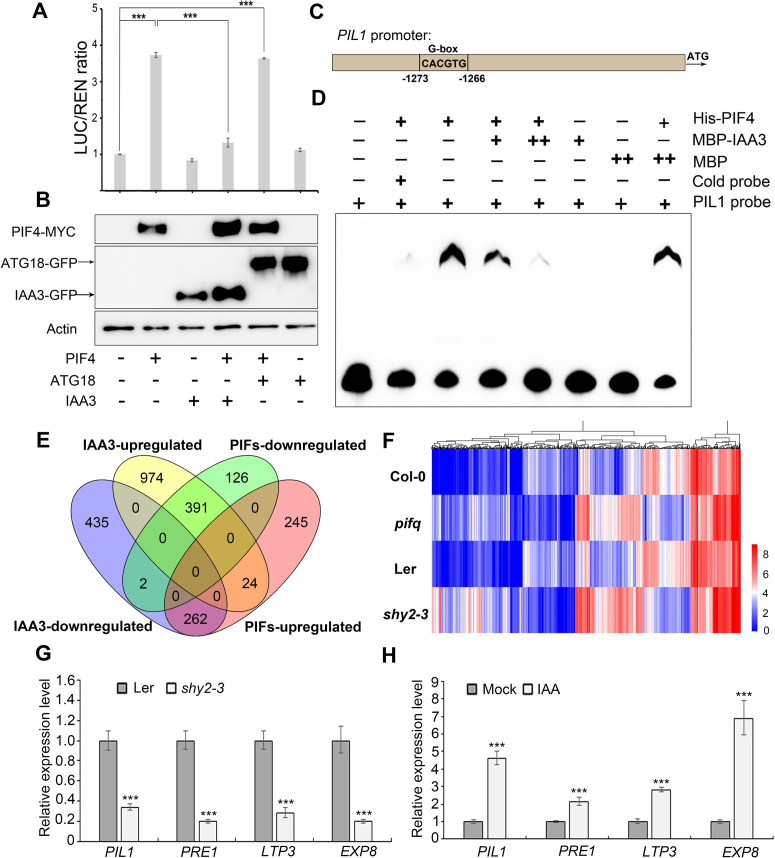
IAA3 impairs PIFs binding to DNA and negatively regulates PIFs’ target genes.(A) The transient dual-LUC reporter assay showing the effects of IAA3 on PIF transcriptional regulation of PIL1. The ATG18-GFP protein is as the negative control in the assay. Data are means ± SD (n = 3 experiments). Significant differences are indicated with asterisks (***P < 0.001, two-tailed Student’s t-test). (B) Western blotting for the detection of expressed PIF4-MYC, IAA3-GFP and ATG18-GFP in transformed tobacco leaves from (A) using an anti-MYC or anti-GFP antibody, respectively. (C) A fragment for PIL1 promoter containing G-box motif (CACGTG) was selected to used as probe in the EMSA experiment. (D) EMSA experiment showing IAA3 inhibition of the DNA-binding activity of PIFs. The cold probe was added as a competitor. MBP was used as a negative control. (E) Venn diagrams showing significant overlap between IAA3-regulated genes and PIFs-dependent genes. Detailed gene information is given in S1 Table. (F) Heat map of 625 DEGs coregulated by IAA3 and PIFs. (G) and (H) qRT-PCR analysis of known PIFs’ direct target genes. The transcription levels of PIFs’ direct target genes in Ler and shy2-3 mutant (G). Auxin induction of PIFs-regulated genes. Five-day Col-0 seedlings grown in light condition were treated with 5 μM IAA for 24 hours (H). The expression was normalized to the ACTIN2 (ACT2) expression level, and was relative to wild-type levels. Data represents mean ±SD from three biological replicates. Significant differences are indicated by ***P < 0.001(two-tailed Student’s t-test).